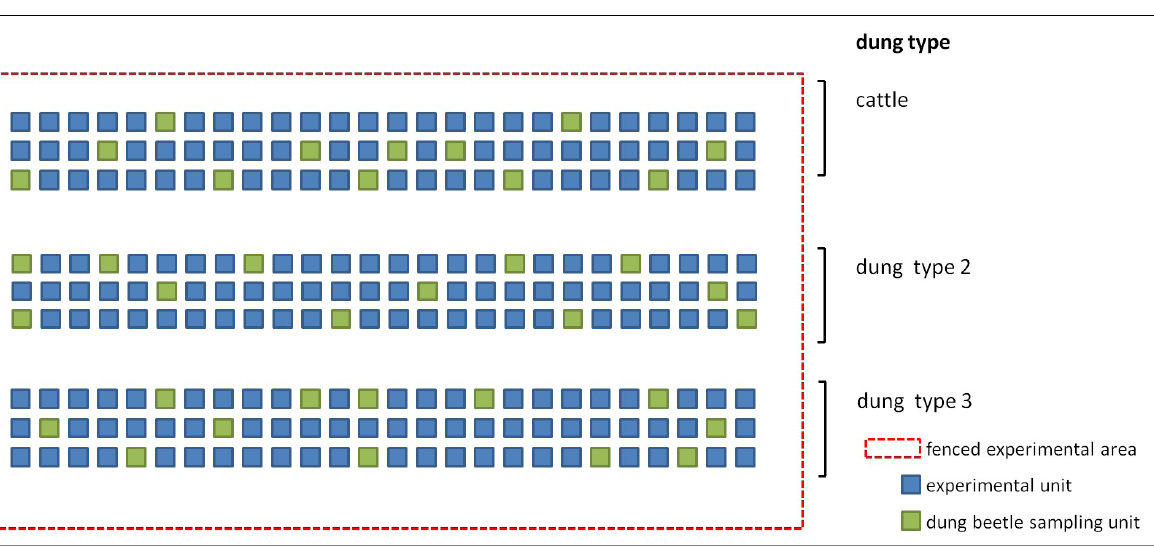
Figure 3. Experimental design with the random distribution of experimental units and dung beetle sampling units grouped by dung types in the fenced experimental area.